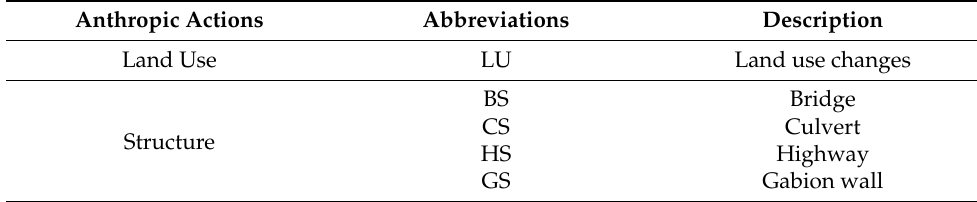
Table 3. Types of human interventions. Modified from Pérez Cutillas et al. [10].